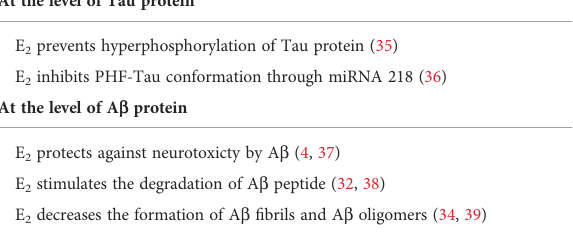
TABLE 1 Summary of Neuroprotective actions of E 2 . At the level of Tau